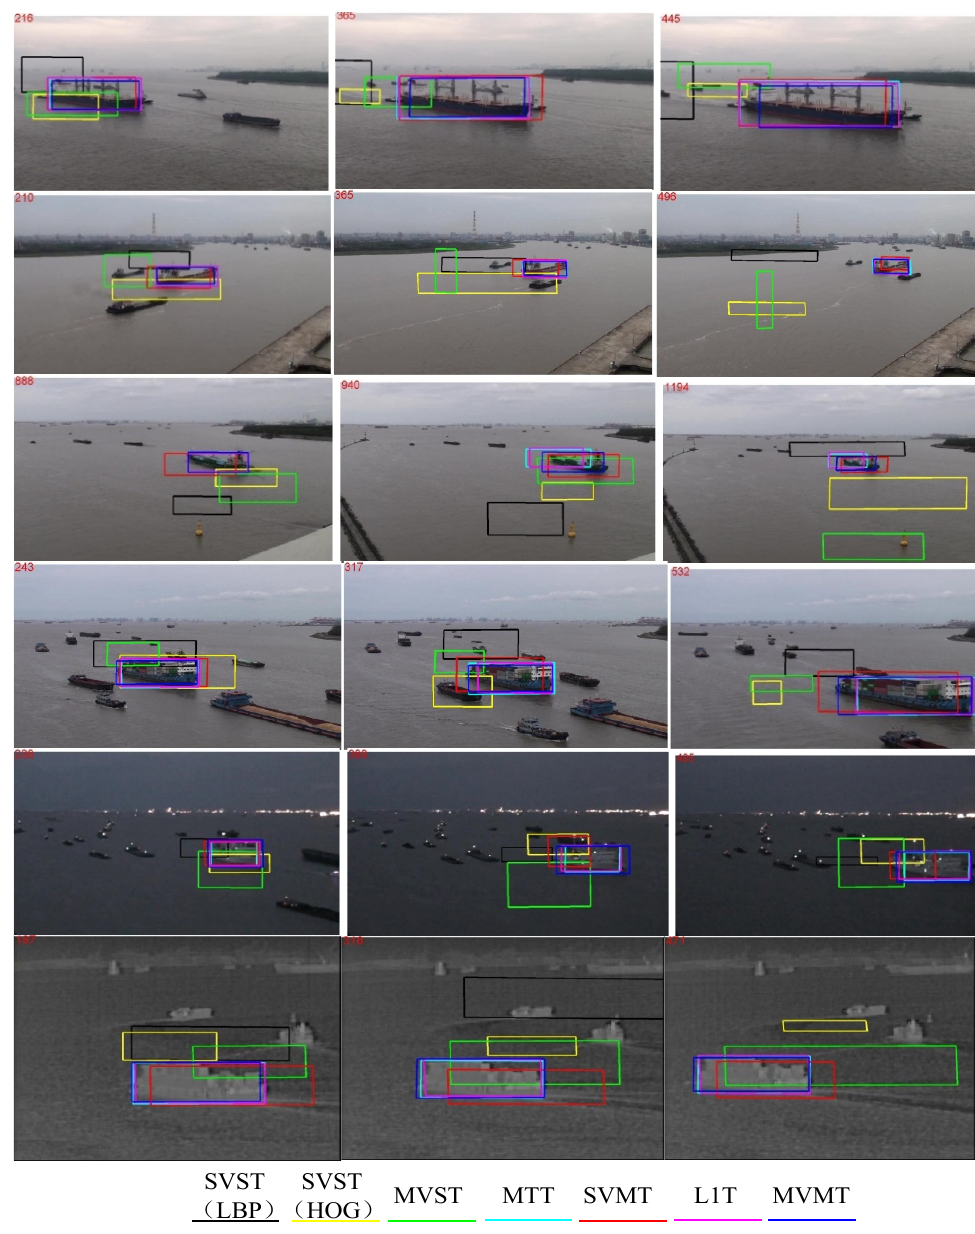
Figure 14. Identification results of 7 algorithms in 6 groups of ship sequence pictures.